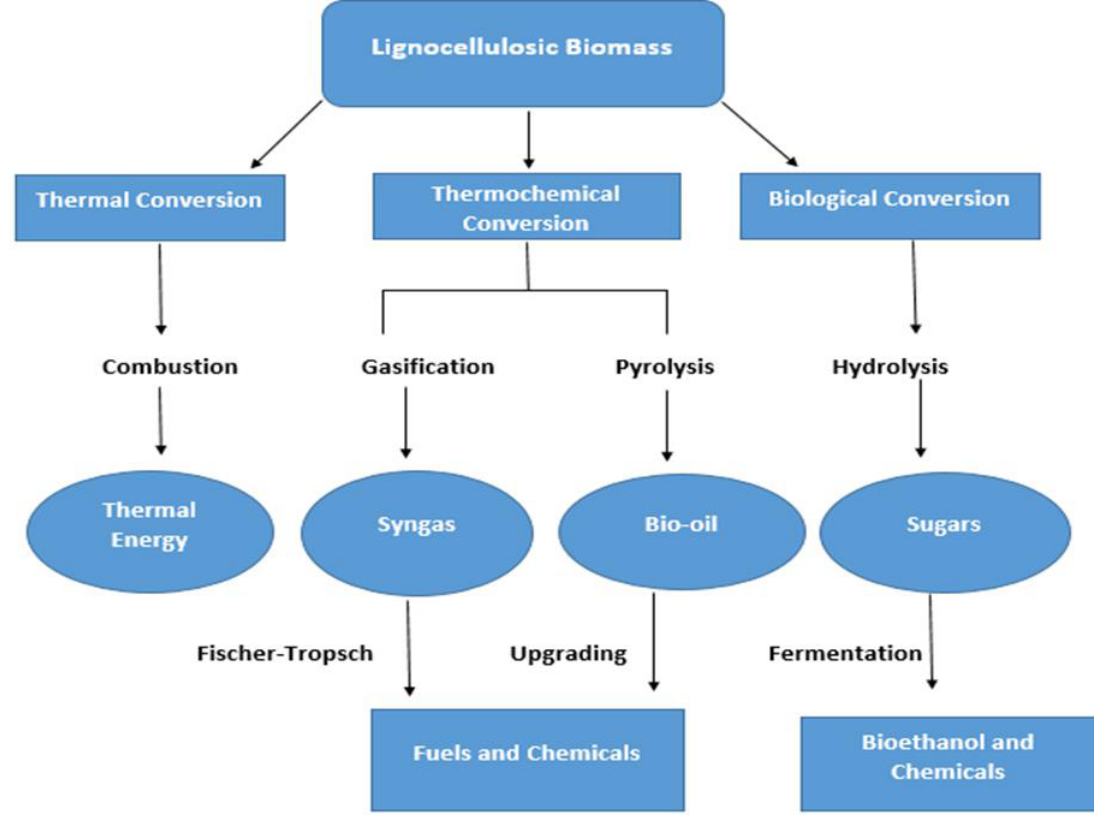
Figure 2. Sequential diagram of different lignocellulosic conversion pathways into value-added products.